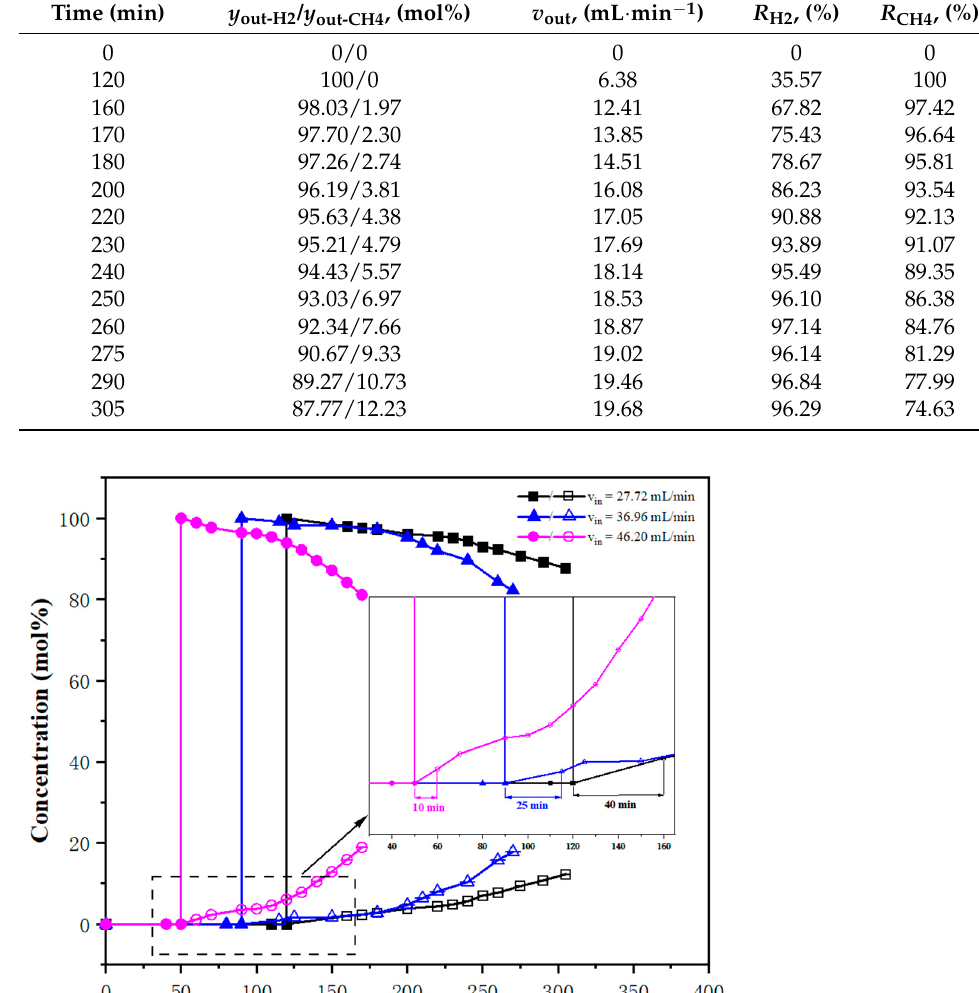
Table 3. Results of the breakthrough experiment for the CH 4 /H 2 (34.22/65.78 mol%) mixture separation in a slurry of ZIF-8 30 wt% + ethylene glycol 14 wt% + water 56 wt% at 273.15 K, 2.0 MPa, with an inlet flow rate of 27.72 mL/min.